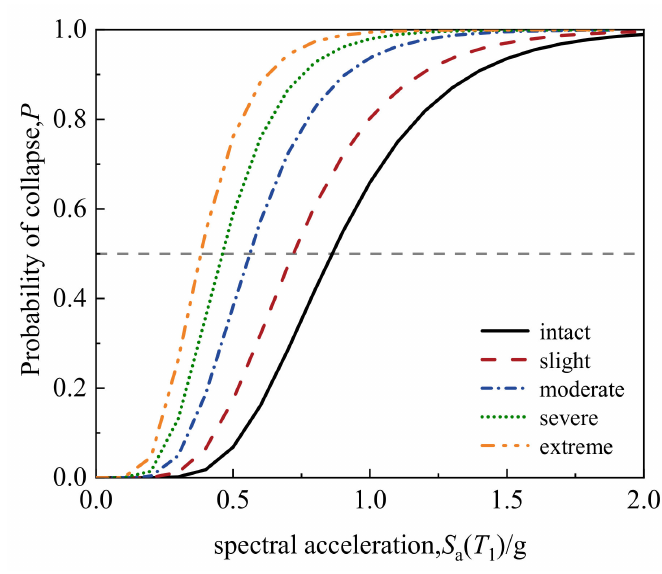
Figure 7. Collapse fragility curves of columns with different damage states.